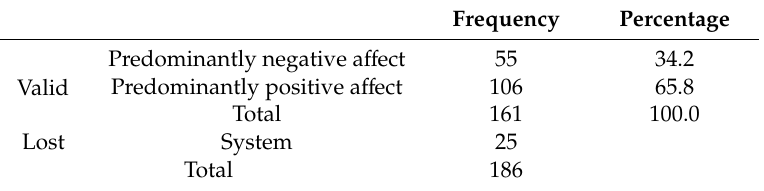
Table 5. Distribution of the sample according to the type of score in